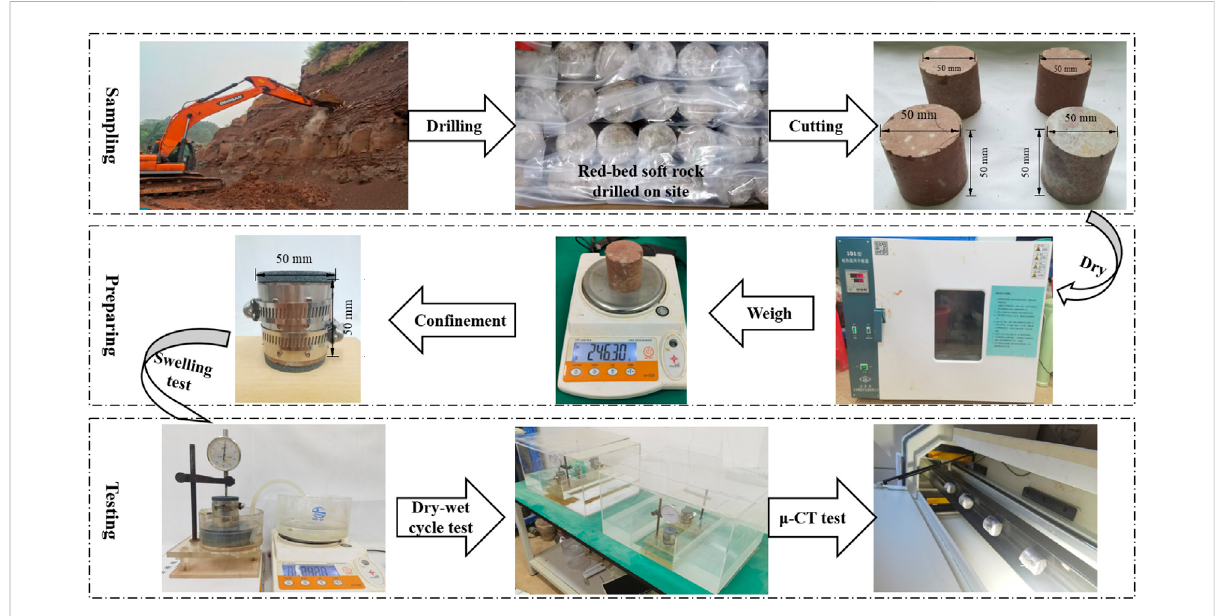
The processing of the red-bed mudstone